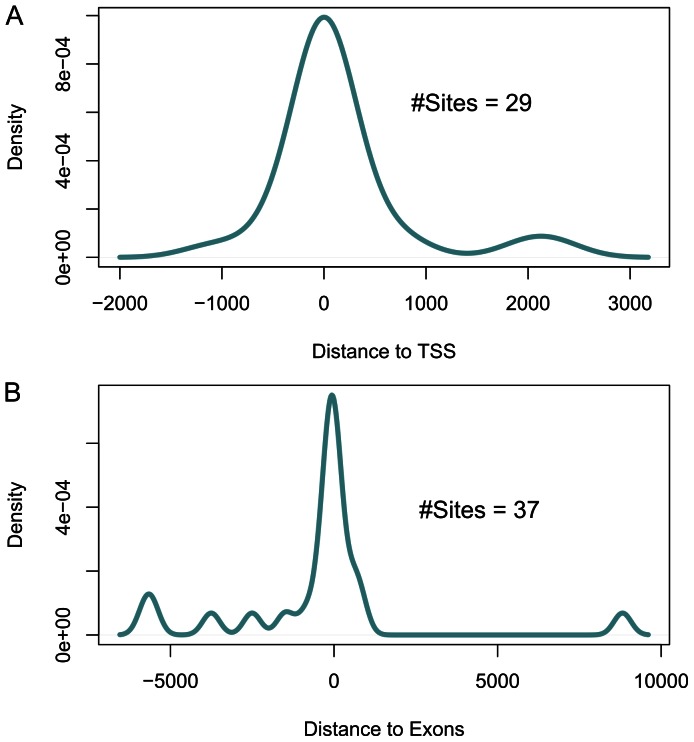
Distance density plot of diffReps-specific sites that are related with alternative promoter usage and alternative splicing.The distance is determined by first looking for the closest TSS or alternative exon and then calculating the number of basepairs between the boundaries of a site and a feature. (A) Distance to TSS; (B) Distance to exon.